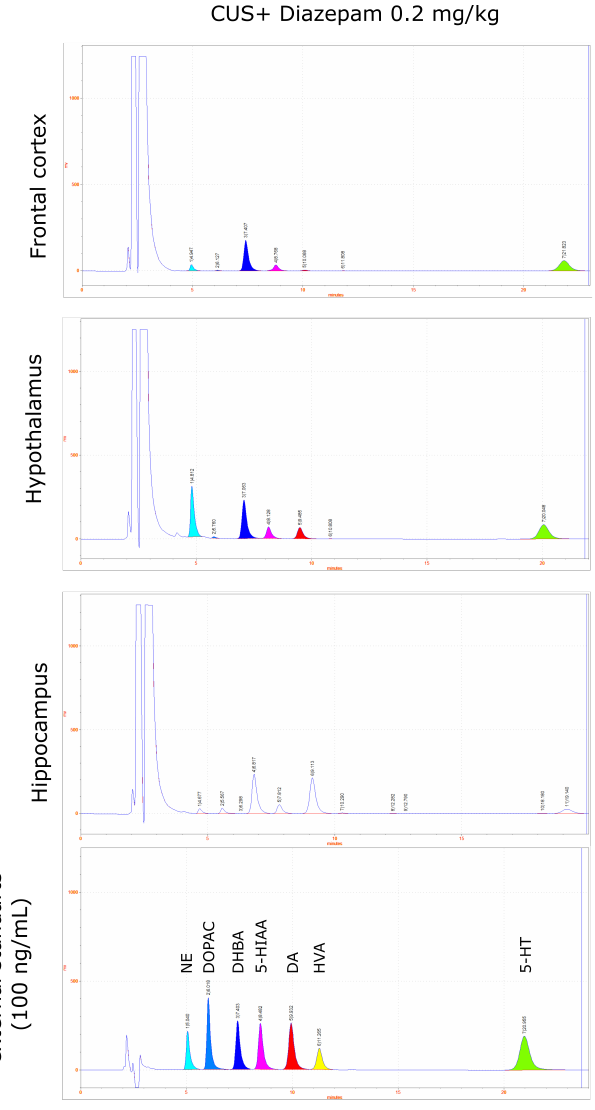
Figure 10. Example chromatograms of monamines NE, DA, and 5-HT and their metabolites (DOPAC, 5-HIAA, and HVA) extracted from the frontal cortex, hypothalamus, and hippocampus after CUS exposure and treatment with diazepam (0.2